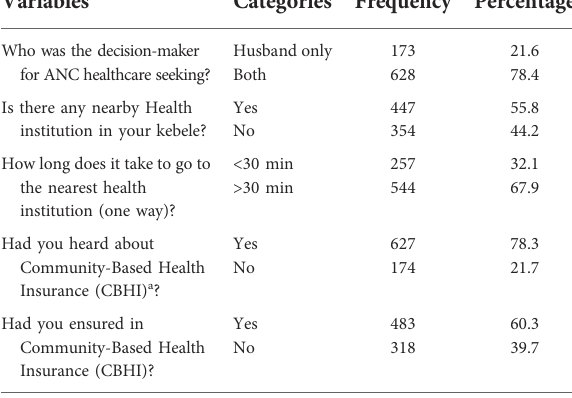
TABLE 2 Personal and environmental factors of male partners of women in their reproductive years (18 – 49 years) in the Bench Sheko zone, Southwest region, Ethiopia,